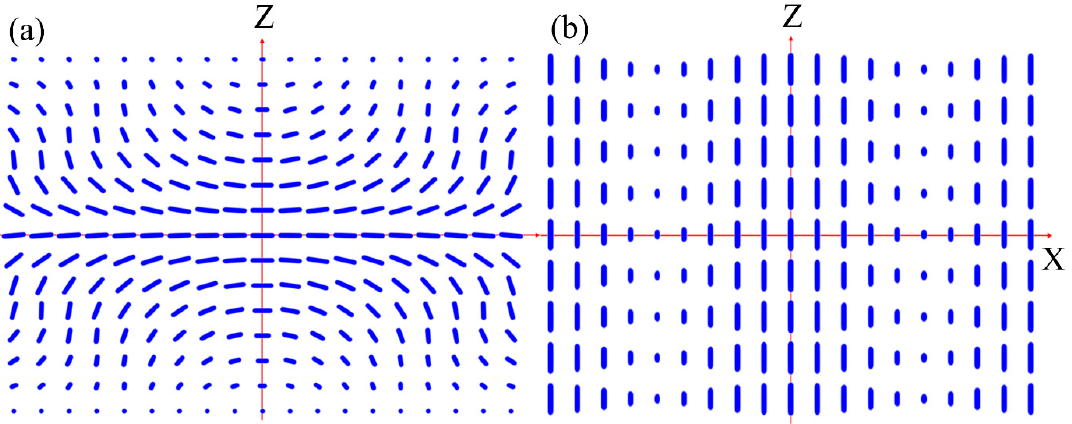
Figure 1. Twisted nematic structures. ( a ) The radially z-twist deformation. Q 1 = 1.0, Q 2 = 1.0. The twist is realised both along the (cid:1857)⃗ (cid:3101) and (cid:1857)⃗ (cid:3053) directions. ( b ) The radially twisted structure. Here, the twist is realised along (cid:1857)⃗ (cid:3045) . Q RT = 1.1.